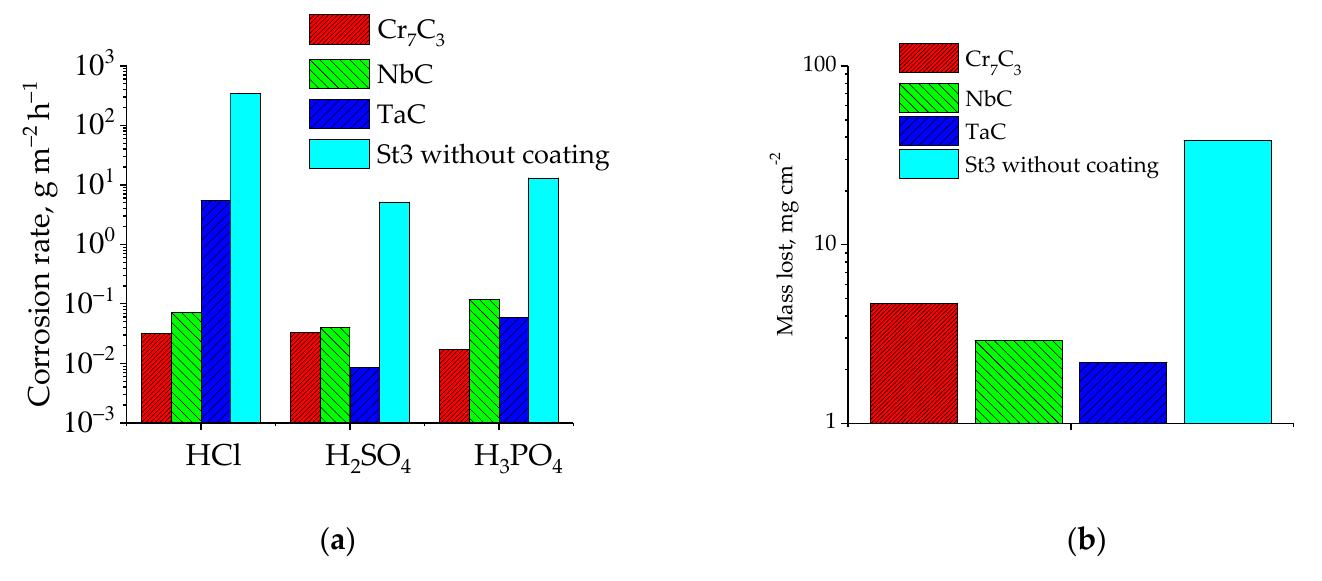
Figure 8. ( a )—Corrosion rates of steel/refractory metal carbide coatings in concentrated mineral acids and ( b )–mass loss due to mechanical wear.